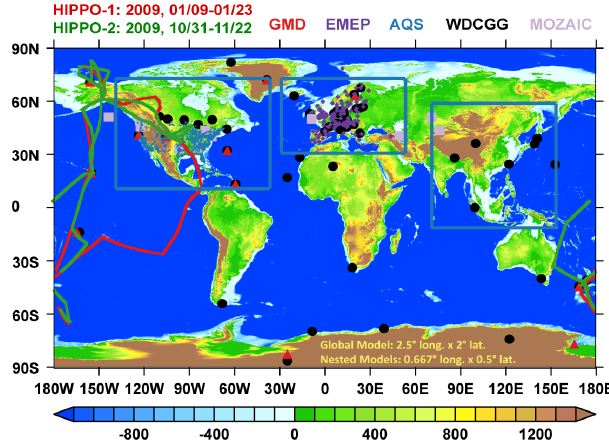
Figure 1. Dark green squares bounding the domains of three nested models covering Asia (70–150 ◦ E, 11–55 ◦ N), North Amer- ica (140–40 ◦ W, 10–70 ◦ N) and Europe (30 ◦ W–50 ◦ E, 30–70 ◦ E). Also shown are sites of ground-level ozone measurements from WDCGG (black circle), GMD (red triangle), AQS (blue triangle) and EMEP (purple diamond); airports in the MOZAIC program for the tropospheric ozone profiles (pink square); and aircraft flight tracks in the HIPPO campaigns (red line for HIPPO-1, and green line for HIPPO-2). The overlaid map is the surface elevation (m) from a 2min Gridded Global Relief Data (ETOPO2v2) available at NGDC Marine Trackline Geophysical database (http://www.ngdc.